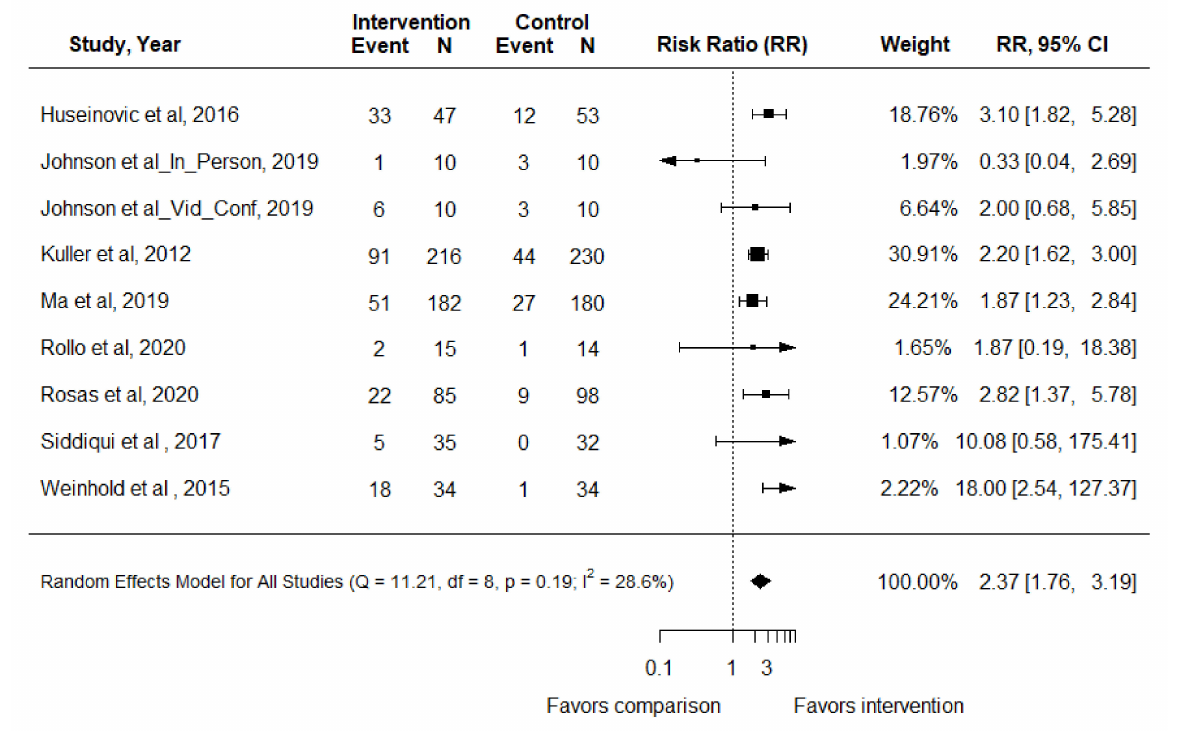
Figure 6. Forest plot for 5% weight loss in the systematic review examining effect of nutrition and physical activity interventions provided by nutrition and exercise practitioners for the general population